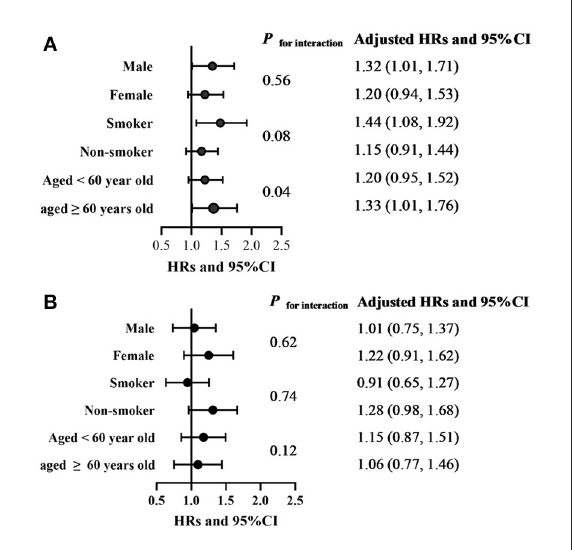
FIGURE2 Subgroup analysis of the associations between solid fuel use and stroke according to age, sex, and smoking status. Cox proportional hazards regression adjusted for age, sex, BMI, family income, education level, smoking and drinking behaviors, marital status, home location (rural or urban area), number of chronic diseases, retirement status, other household solid fuel uses and outdoor air-pollution exposure to PM 2.5 . (A) Analysis of the associations between solid fuel use for cooking and stroke. (B) Analysis of the associations between solid fuel use for heating and